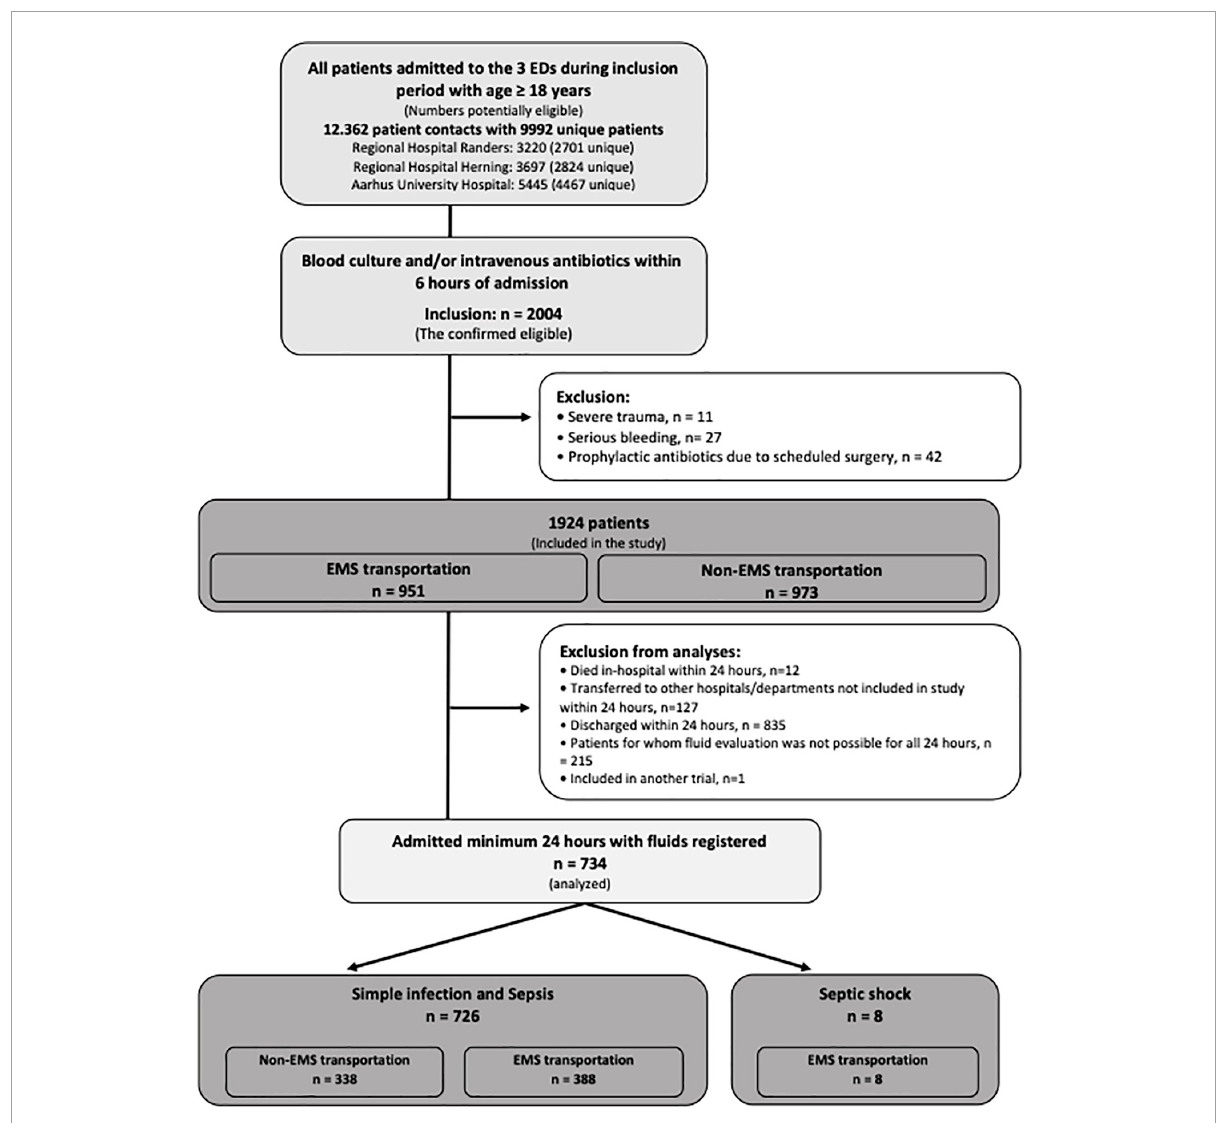
FIGURE1 Flow chart of this figure shows patient flow and transportation status.